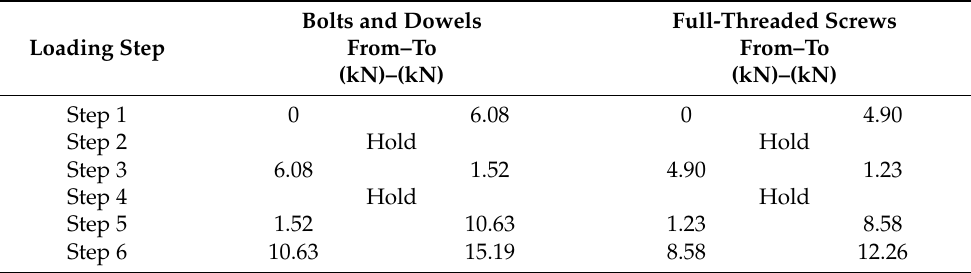
Figure 10. Load curves of the individual experiments. Table 4. The test course of the experiment